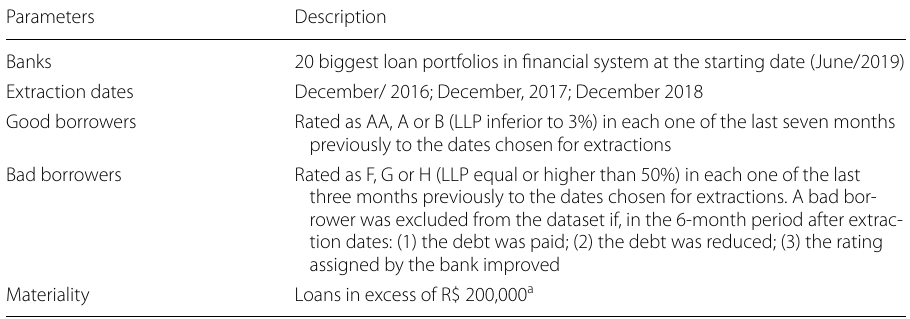
Table 4 Parameters and criteria adopted to classify borrowers according to banks’